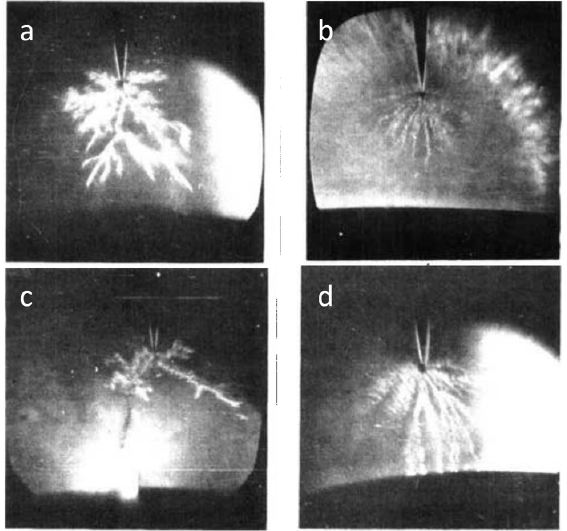
Figure 18. Typical Schlieren images of the pre-breakdown disturbances between point-plane electrodes in pure transformer oil; ( a ) negative point: 60 kV and 2 µs pulse duration, ( b ) positive point: 45 kV and 2 µs pulse duration, ( c ) negative point: 45 kV and 9–6 µs pulse duration and ( d ) positive point: 45 kV and 2–7 µs pulse duration. Reproduced by permission of the Institution of Engineering & Technology [30].